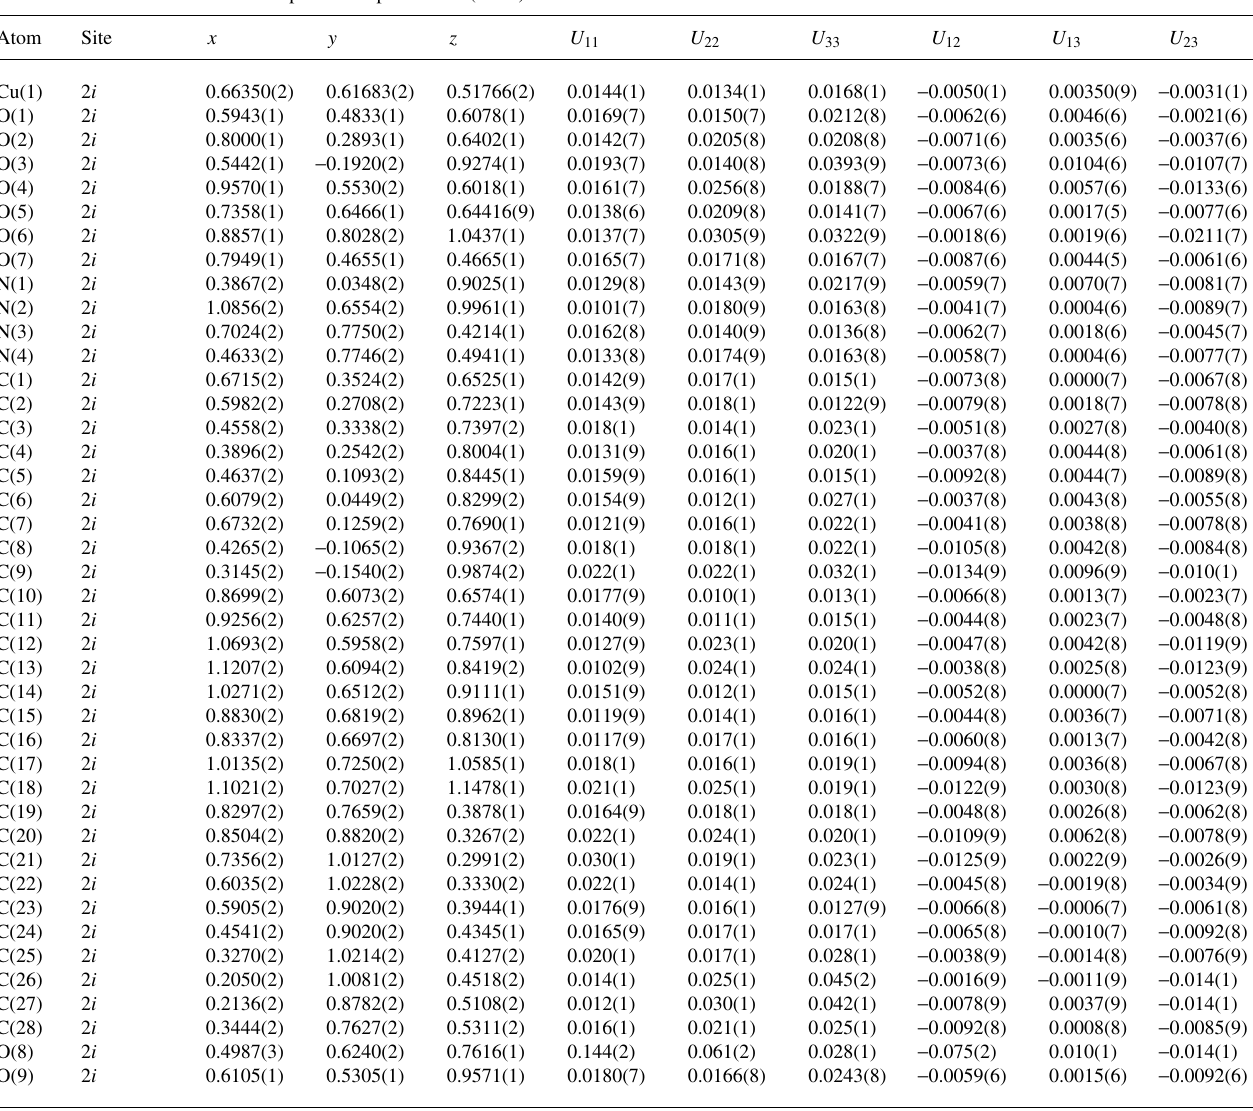
Table 3. Atomic coordinates and displacement parameters (in Å 2 )